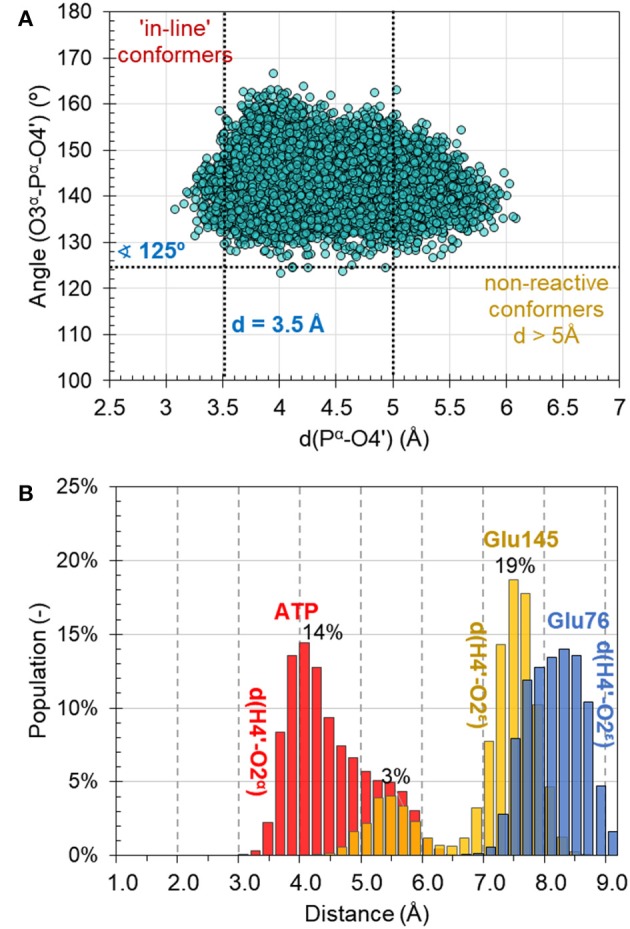
(A) Population of structures of reactant complex generated along the 10 ns of classical AMBER/TIP3P at NVT MD simulations as a function of the O3α-Pα-O4′ angle and the O4′-Pα distance. (B) Distribution of catalytically important distances along MD simulations.